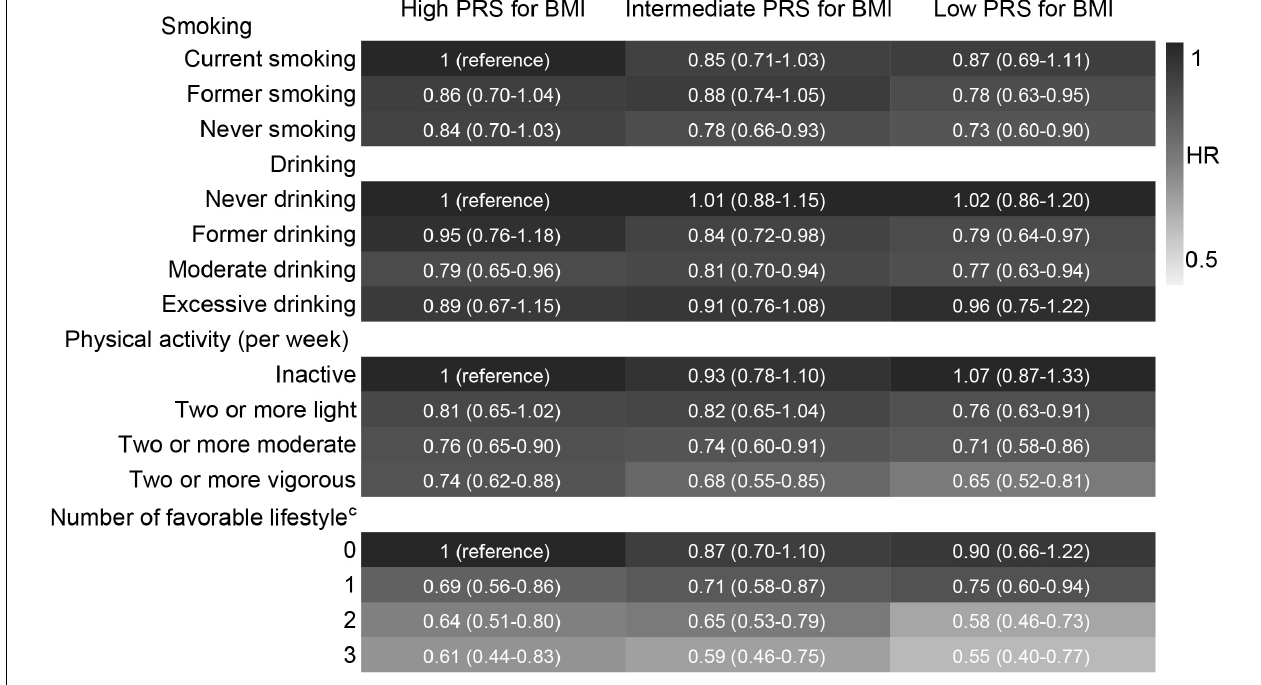
FIGURE 6 | Risk of cognitive impairment according to the combination of lifestyle and PRS for BMI. HRs (95% CIs) were presented: light grey means protective. The model adjusted for smoking, drinking, physical activity, baseline age, sex, education, marriage, family wealth per capita, and body weight status. c Moderate drinking was considered favourable. PRS, polygenic risk score; BMI, body mass index. The significance level was set at α =